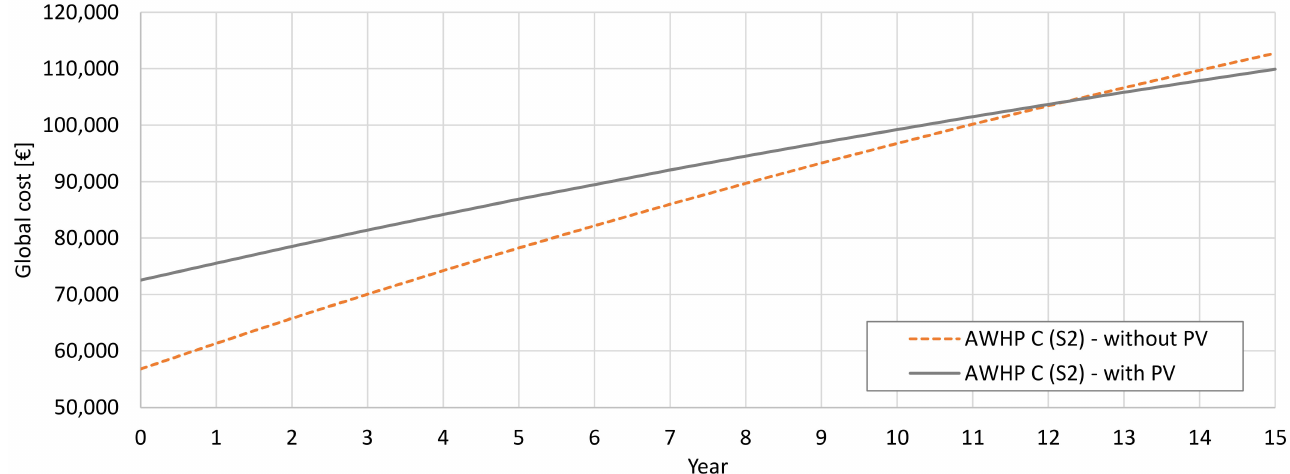
Figure 14. Payback period for cost optimal system AWHP